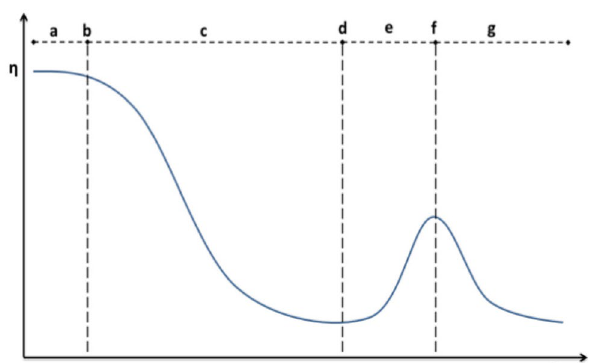
Fig. 7 Typical HPAM viscosity curve (Skauge et al. 2016)